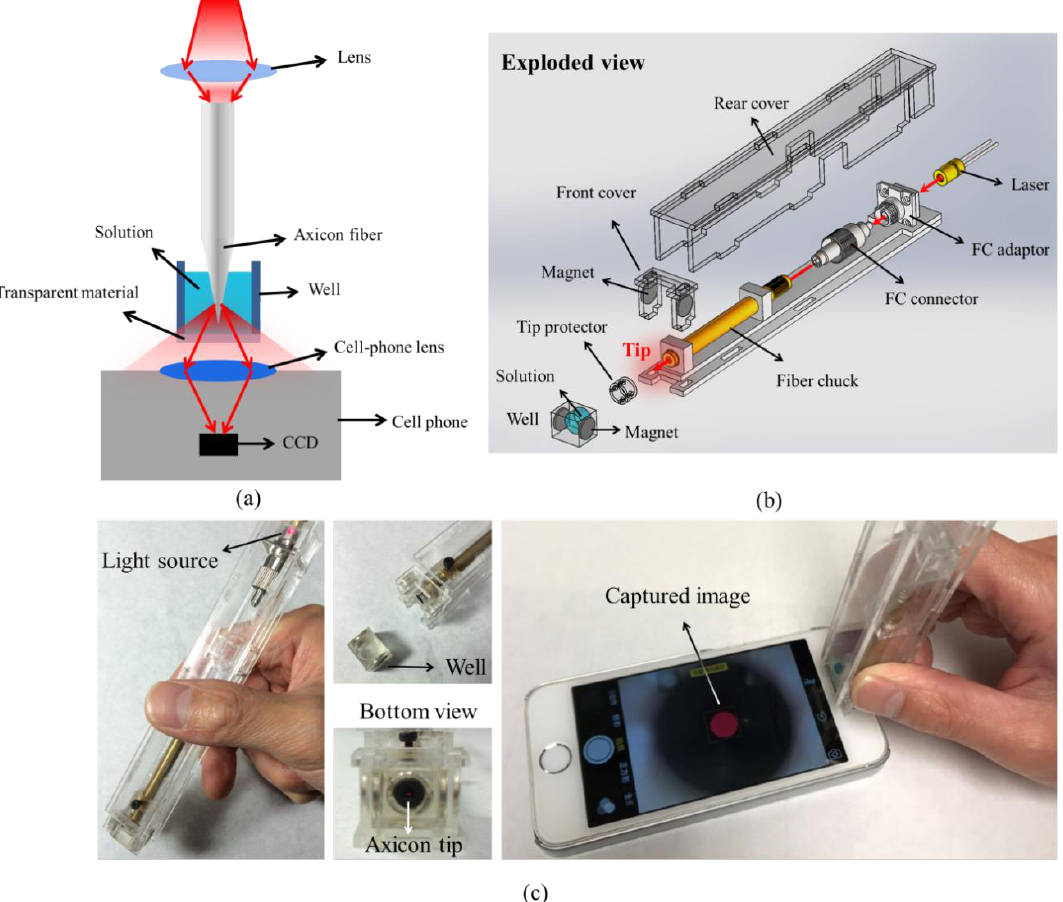
Figure 4. ( a ) The schematic of the optical axicon tip sensor combined with a smartphone camera for detection; and ( b ) the design and ( c ) photos of the portable axicon fiber tip sensor and detection using the front camera of a